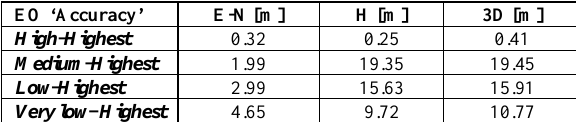
Table 2. RMSE of coordinates of 11 CP’s computed on the basis the EO parameters obtained from processing at